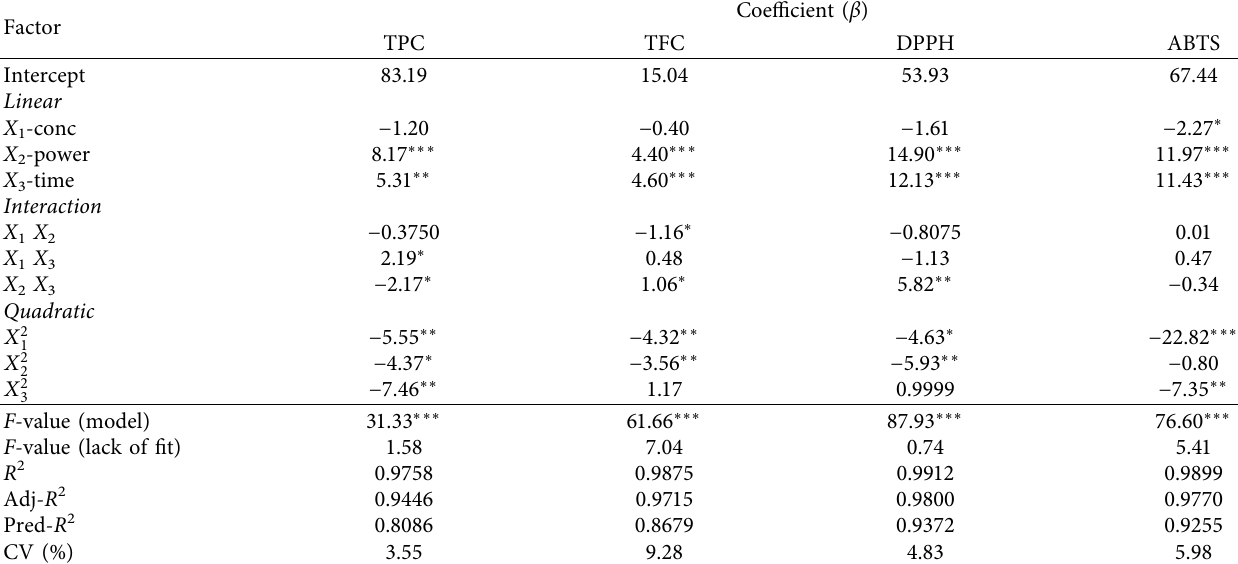
Table 3: Regression coefficient ( β ) and analysis of variance (ANOVA) of the predicted second-order polynomial models for phenolic compounds and antioxidant activity.